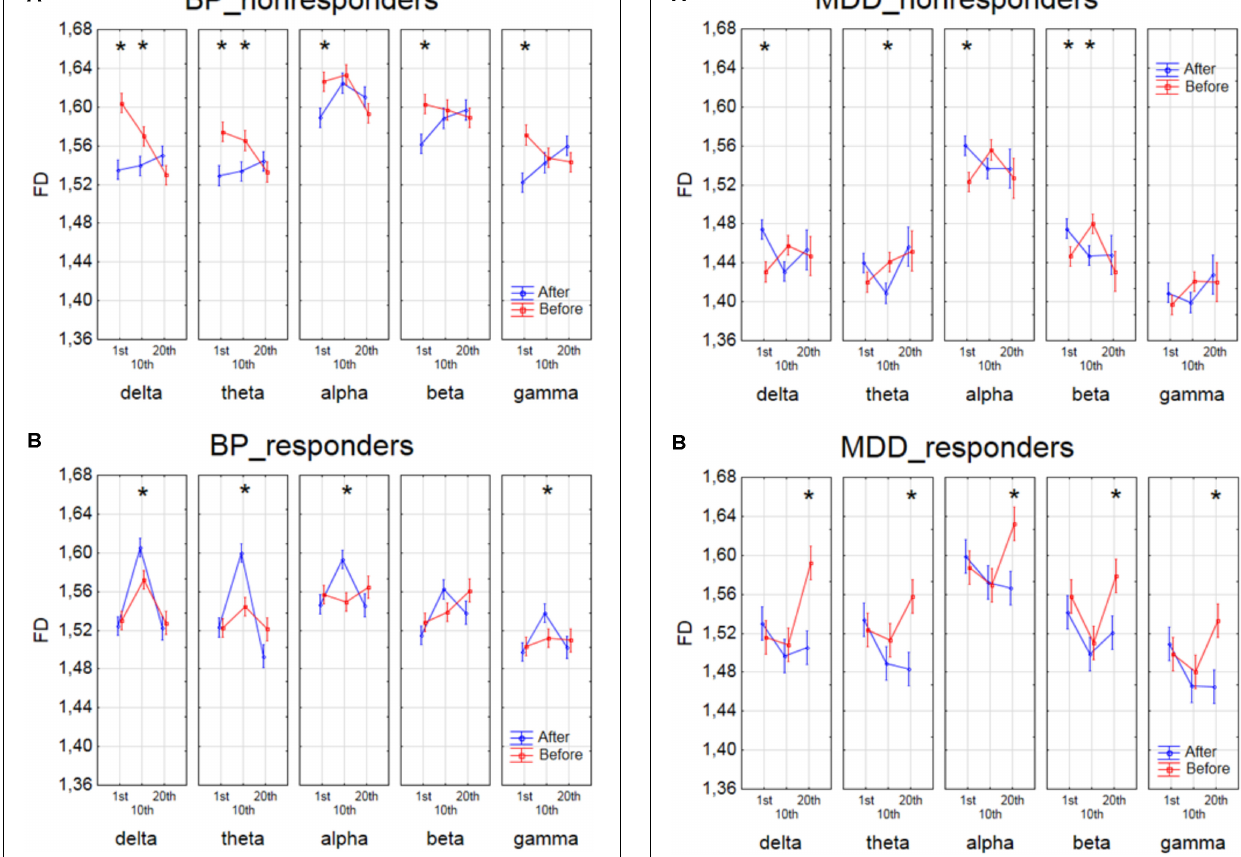
FIGURE 5 | Higuchi fractal dimension for MDD_non-responders group (A) and for MDD_responders group (B) for each band separately, showing changes in FD values before and after 1st, 10th and 20th session. The interaction between factors CONDITION, BAND and SESSION (separately for every group of MDD patients). Significant differences between conditions for the individual sessions and bands, evaluated by post hoc Tukey HSD test, were marked with